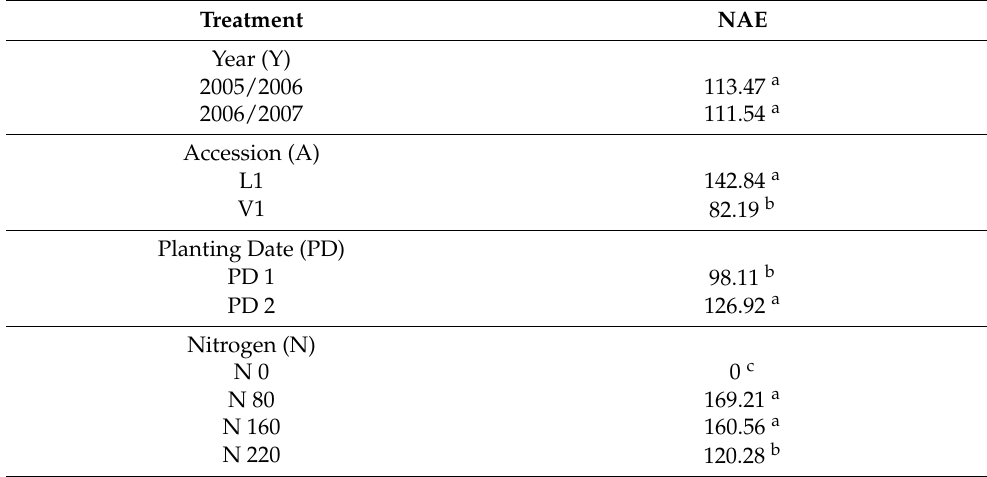
Table 5. Nitrogen agronomy efficiency (NAE) in response to year (Y), accession (A), planting date (PD), and N dose (N).